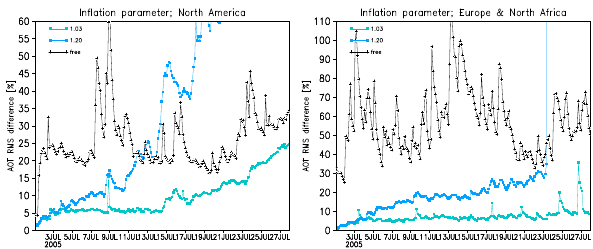
Fig.7. Area-averageddifferences[%]inAOT,forvarious ρ experiments.The R128E2P4 experimentsisusedasthereference. Fig. 7. Area-averaged differences [%] in AOT, for various ρ exper- iments. The R128E2P4 experiments is used as the